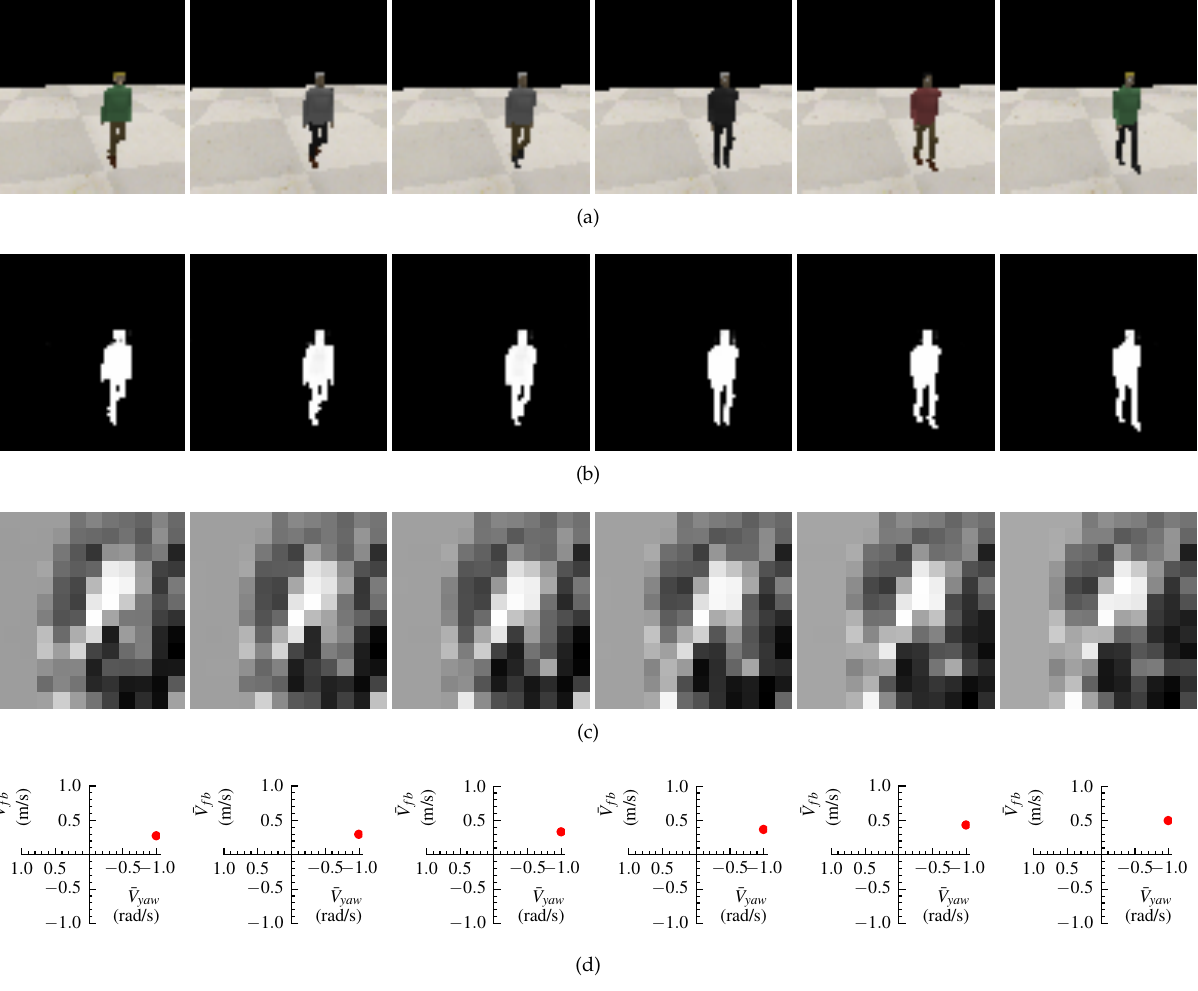
Figure 13. Visualization of layers and output commands in the RL controller, given a sequence of raw observations from timesteps t = 880 to t = 885. ( a ) Sequence of raw observation: O 880 to O 885 . ( b ) The corresponding output of the position perception layer: Z 880 to Z 885 . ( c ) The corresponding output of the velocity perception layer: W 880 to W 885 . ( d ) The final commands of the RL controller ¯ V fb , ¯ V yaw